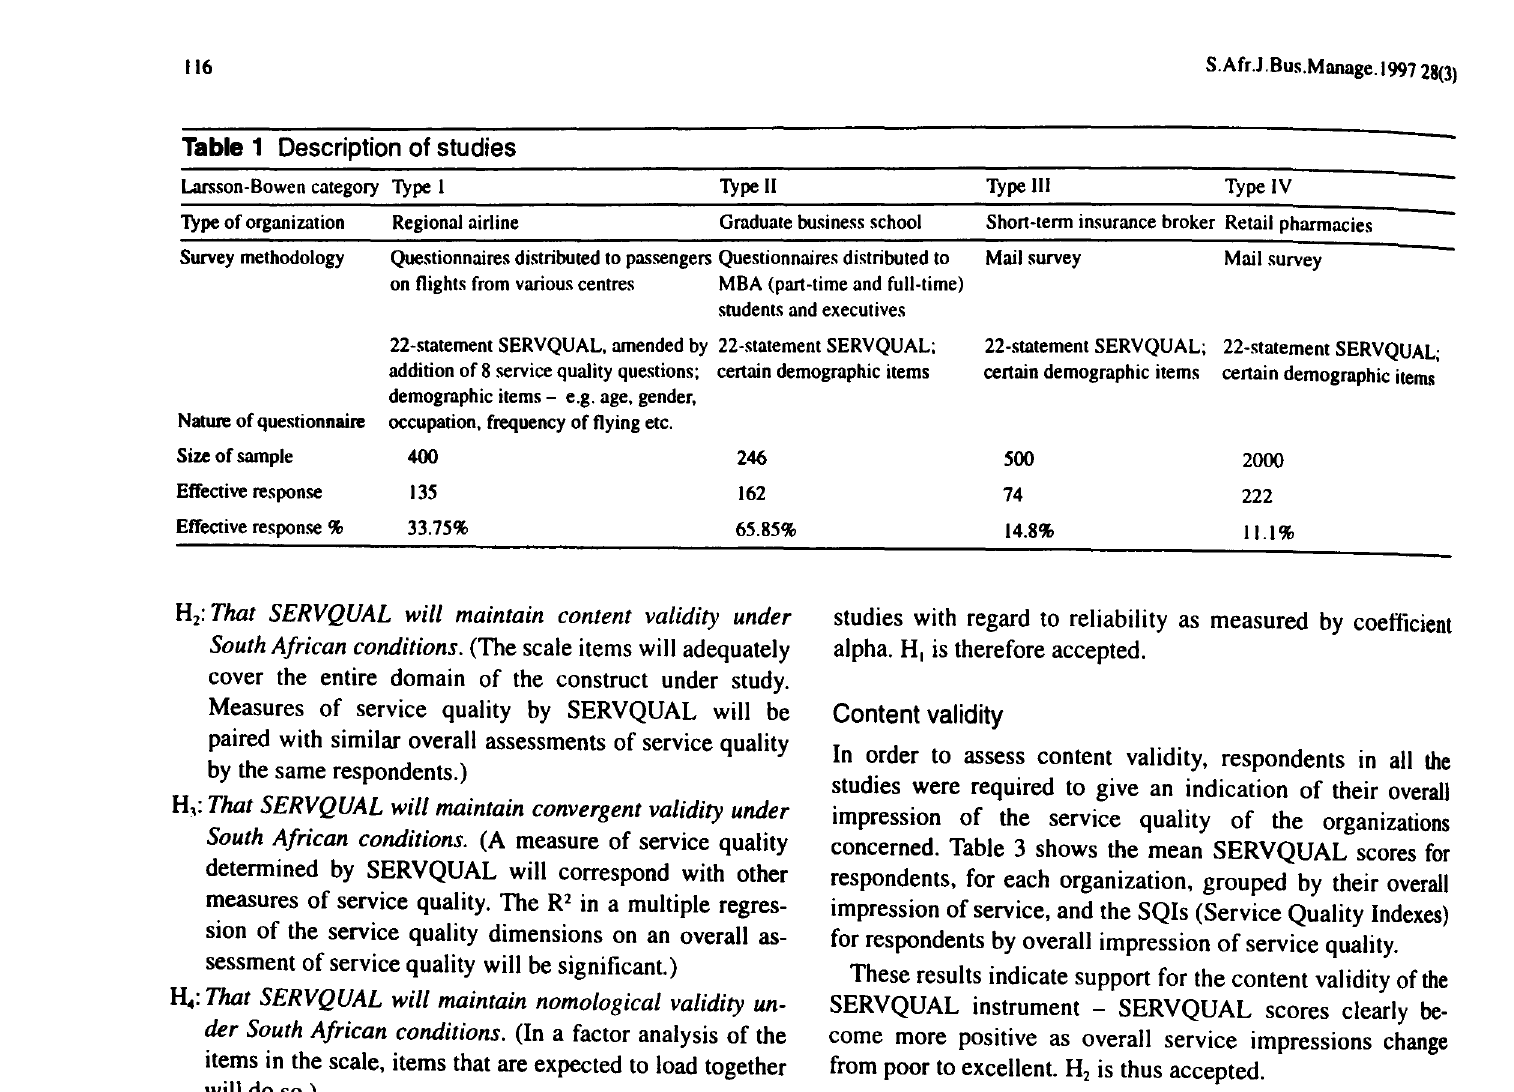
Table 2 Instrument reliability: coefficient a for